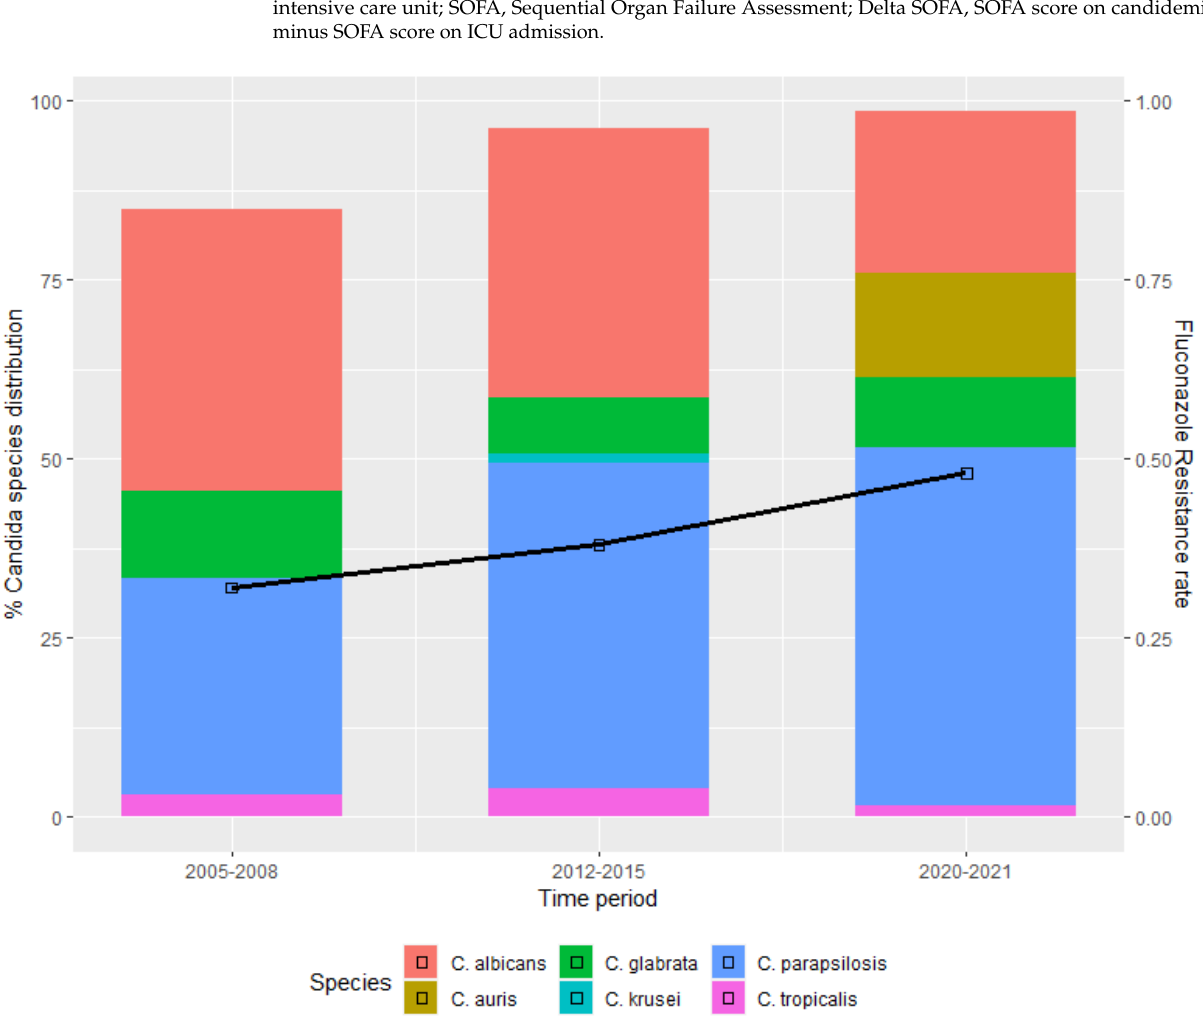
Figure 1. Species distribution of Candida bloodstream isolates and fluconazole resistance before and during the COVID-19 pandemic era. During the COVID-19 period, fluconazole resistance occurred in 30 (48.4%) can- didemia cases: 2/15 in C. albicans , 17/31 in C. parapsilosis , 3/6 in C. glabrata , 9/9 in C. auris ;